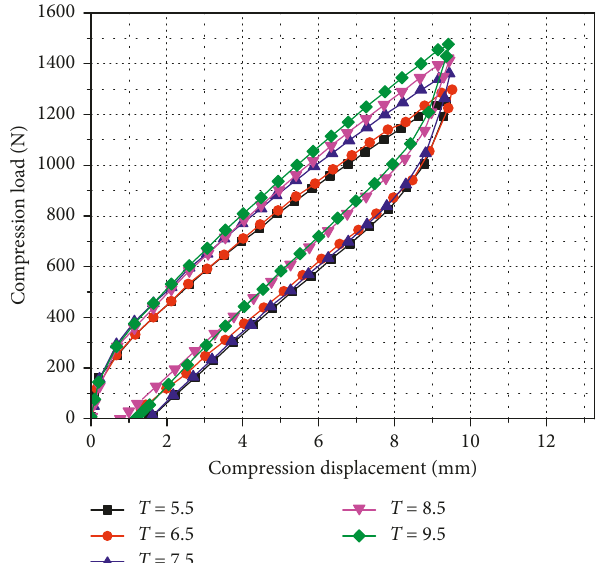
Figure 8: Hysteresis curves comparison of the GGQ-99 WRI with different arc rope lay pitches.